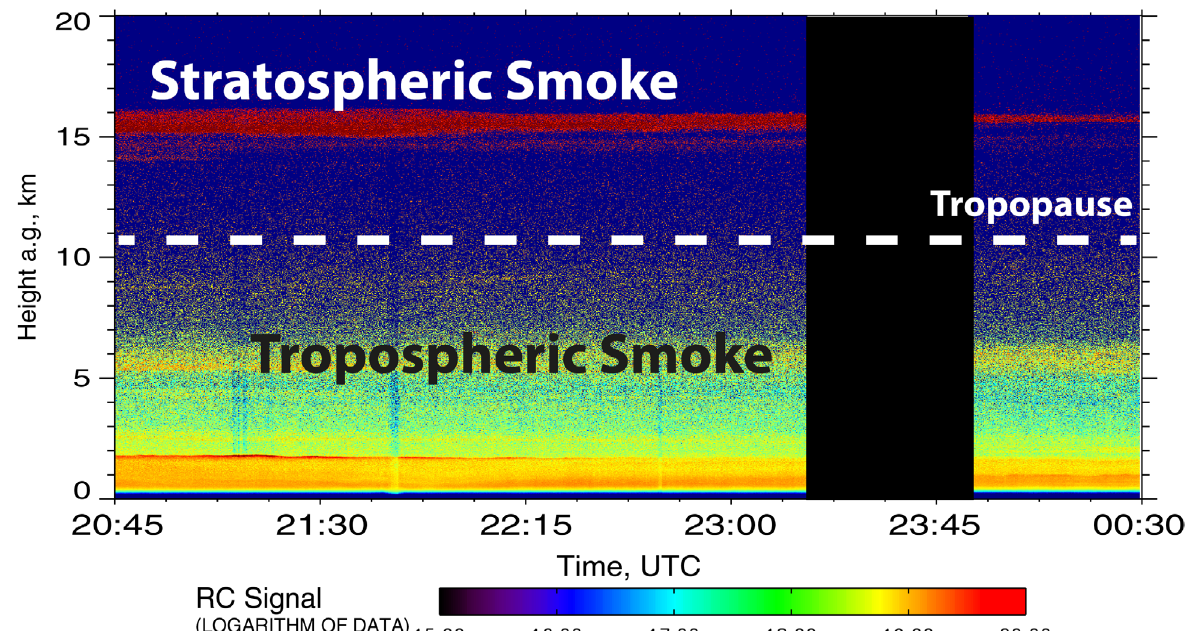
Figure 1 BERTHA measurements of stratospheric and tropospheric smoke layers over Leipzig on 22 August 2017. The change from the 1064 nm extinction measurement to the 1064 nm depolarization-ratio measurement including calibration caused the gap in the measurements (23:15-23:50 UTC). The range corrected signal at 532 nm (cross polarized) is